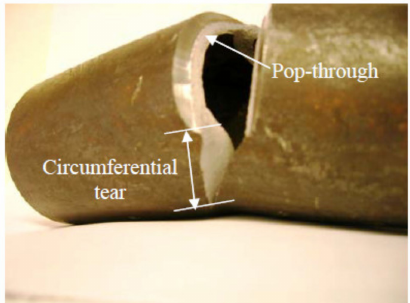
Figure 4. Typical pipe failure from 3-point bending test.